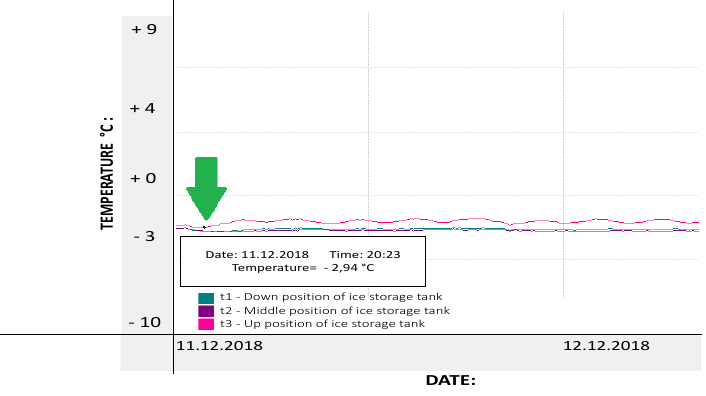
Figure 19. IV. Phase: 0—Solid state.